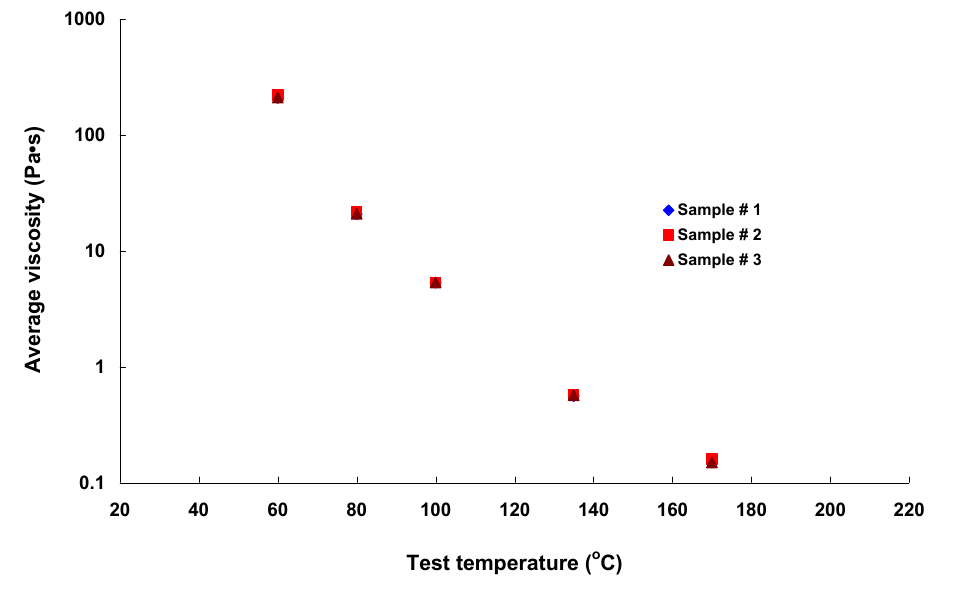
Figure 4. Viscosities of asphalt samples from a Brookfield rotational viscometer at 60, 80, 100, 135, and 170